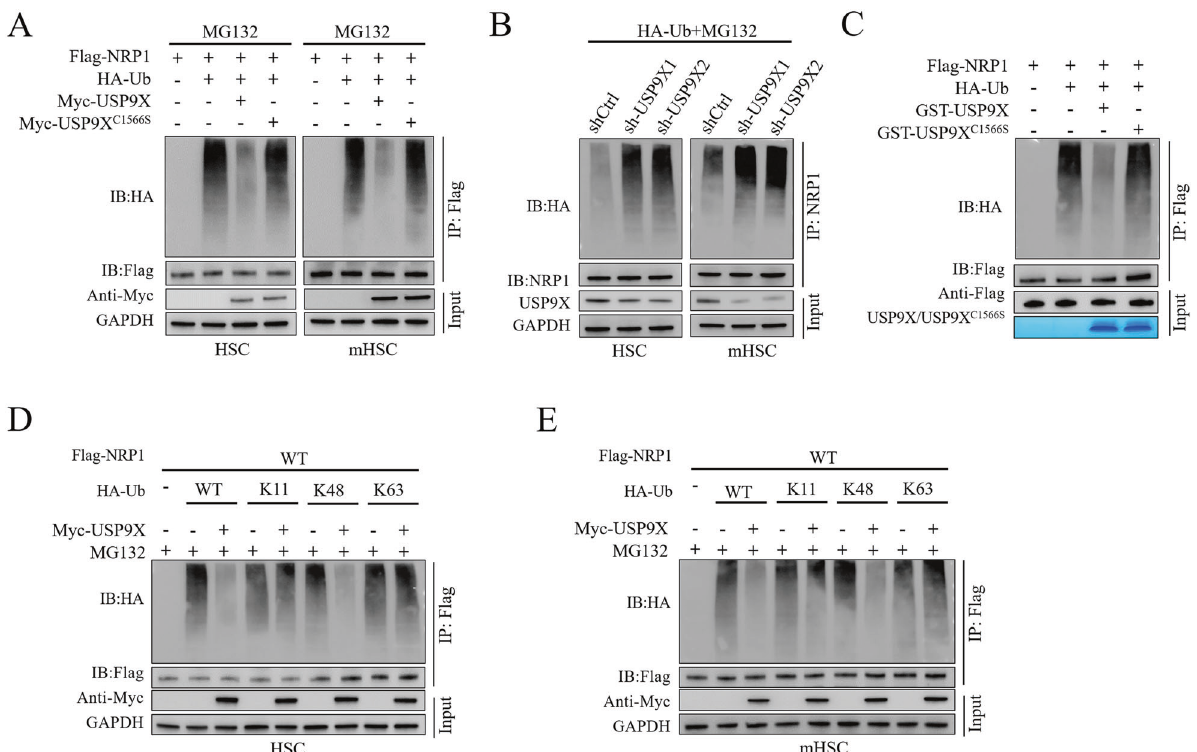
Fig. 5 USP9X deubiquitinates NRP1. A Primary mouse HSCs and murine HSCs were co-transfected with Flag-NRP1HA-ubiquitin (HA-Ub), and Myc-USP9X WT or Myc-USP9X C1566S for 24 h, cells were then exposed to MG132 (10 μ M) for 8 h. Ubiquitination level of NRP1 was evaluated IP with Flag beads and IB analysis antibodies against HA a ( B ). Primary mouse HSCs and murine HSCs were transfected with HA-Ub for 24 h, followed by USP9X knockdown with shRNA targeting USP9X for 72 h. Cells were then exposed to MG132 (10 μ M) for 8 h. Ubiquitination level of NRP1 was evaluated IP with Flag beads and IB analysis antibodies against HA ( C ). GST-USP9X C1566S or GST-USP9X WT coupled to glutathione-Sepharose beads were treated with unubiquitylated or ubiquitylated Flag-NRP1, followed by Flag-NRP1 evaluation by IP with Flag beads and then IB evaluation was carried out with antibodies against HA and Flag. SDS-PAGE and Coomassie blue staining were used to examine recombinant GST-USP9X or GST-USP9X C1566S. D , E Murine HSCs ( D ) or primary mouse HSCs ( E ) were co-transfected with